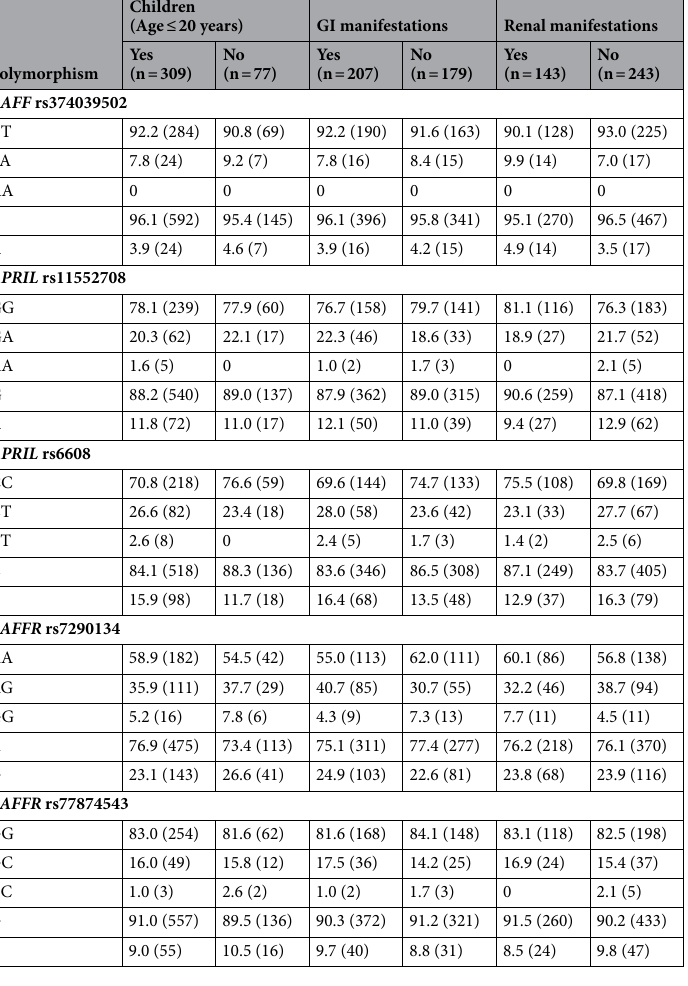
Table 3. Genotype and allele frequencies of BAFF, APRIL and BAFFR in patients with IgAV stratified according to specific clinical characteristics of the disease. IgAV: IgA vasculitis; GI: gastrointestinal. No statistically significant differences in BAFF, APRIL and BAFFR genotype and allele frequencies were disclosed between patients with IgAV stratified according to the age at disease onset or the presence/absence of GI or renal manifestations (p ≥ 0.05 in all the cases).